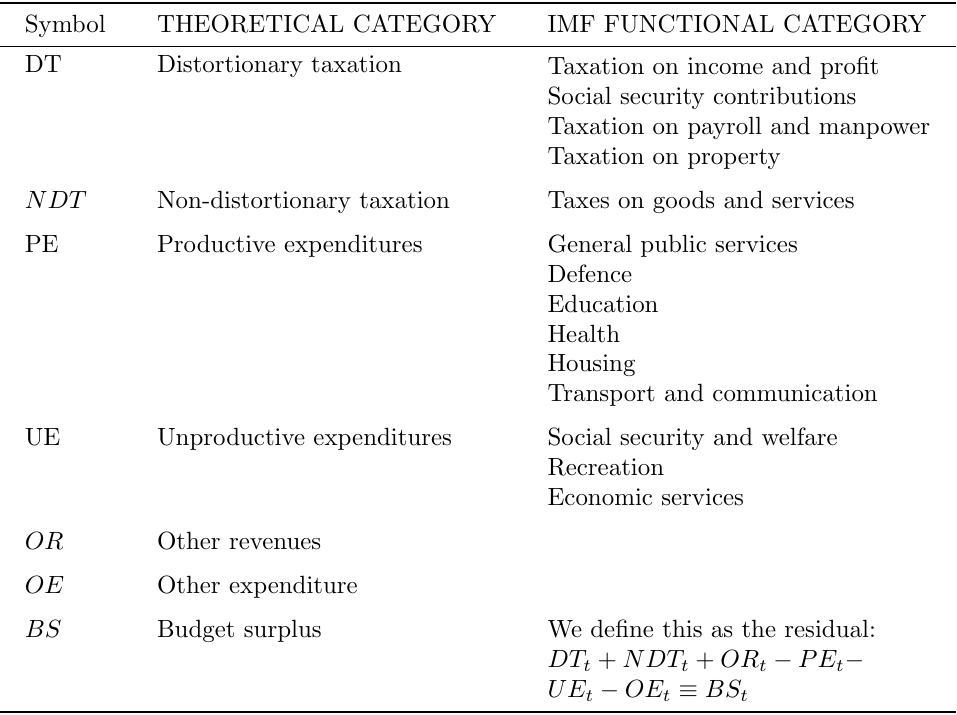
Table A.1: Fiscal variable classifications